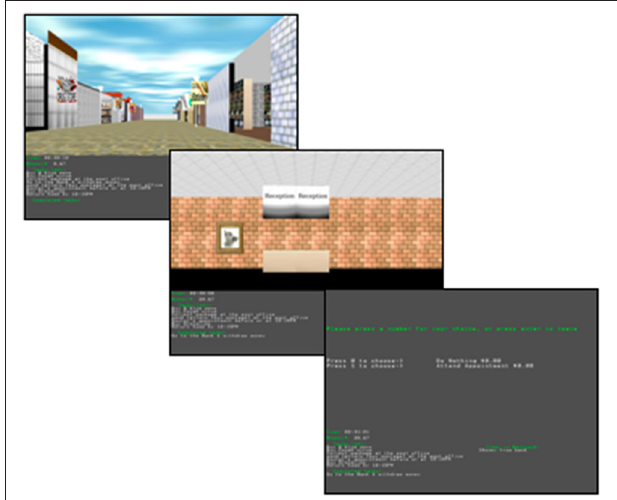
FIGURE 5 | Screenshots of the virtual city in the Multitasking in the City Test [MCT; (